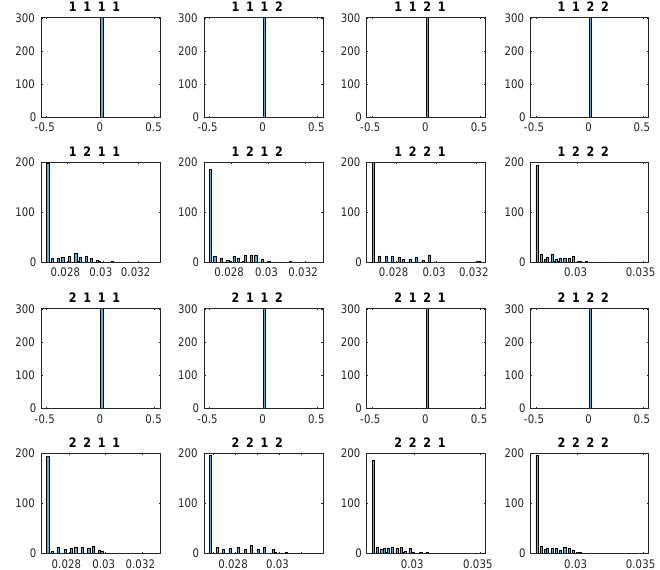
Figure A2. Histograms for all the population groups corresponding to the performance measure of the expected uncertainty of the filter. The horizontal axes represent the expected uncertainty in meters, and the vertical ones, the number of